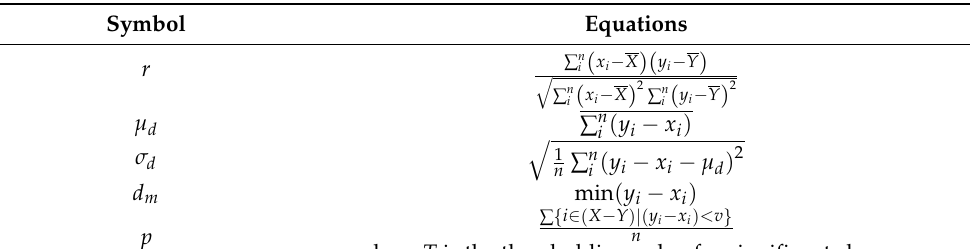
Table 2. List of the five change features; where x i , y i are the pixels within the bridge outline in the pre- and post-event SAR images respectively, and ∗ means the average value.